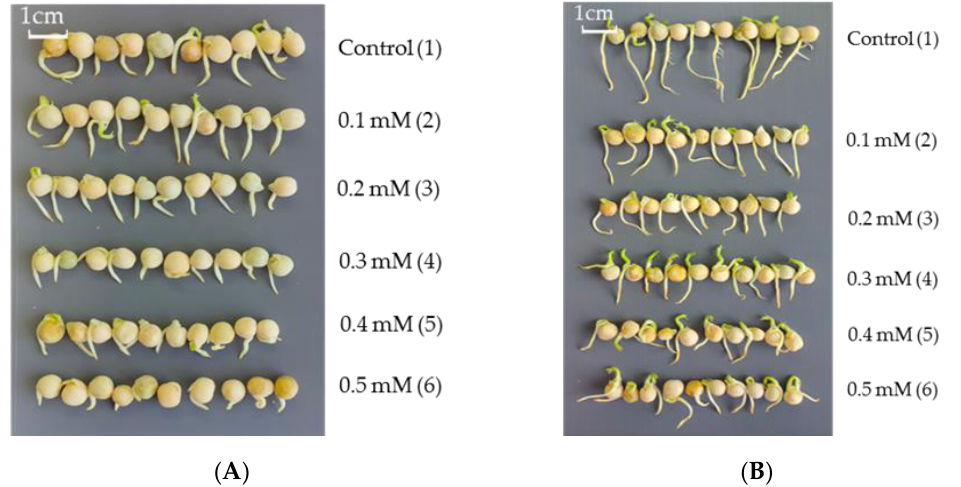
Figure 3. Effect of Cd on the growth of pea seeds germinated on filter paper in sterile water (control) and in the presence of Cd: 0.1, 0.2, 0.3, 0.4, 0.5 mM ( A ); the second variant of the seeds was treated with Pseudomonas sp. OBA 2.4.1 and also grew in the presence of Cd: 0.1, 0.2, 0.3, 0.4, 0.5 mM ( B ). The bar in the photograph indicates 1 cm.